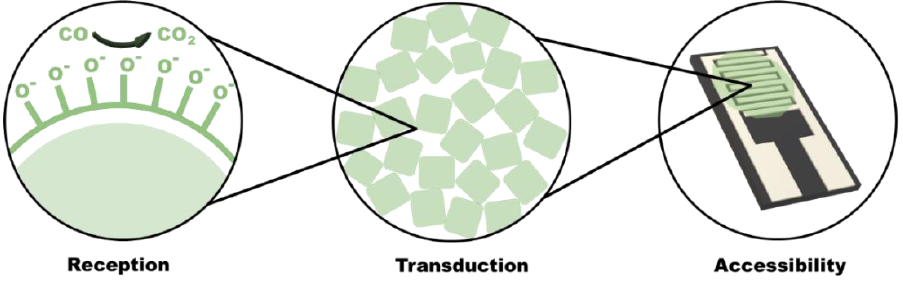
Figure 4. Processes involved in chemiresistive gas sensing: Left—reception mechanism: corresponds to the catalytic reaction between the adsorbed oxygen ions on the surface of the sensing material and the analyte molecules and relates with sensitivity and selectivity of the sensor. Centre—transduction mechanism: responsible for the conversion of change in reactive energy to readable device resistance. Right—accessibility mechanism: describes variation due to diffusion of analyte molecules within the grain boundaries of the SMO layers.